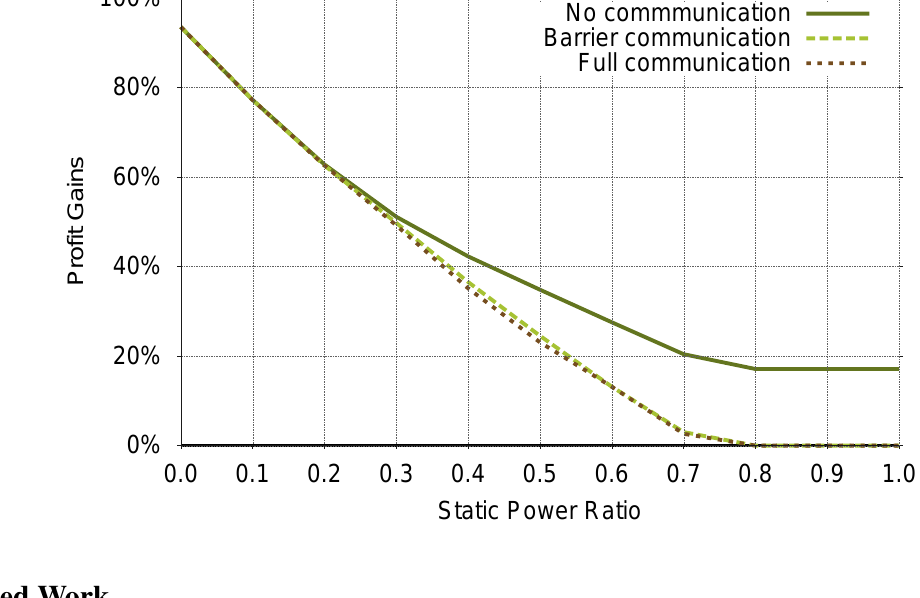
Figure 9. Profit gains of Shadow Replication over Traditional Replication for different static power ratio. MTBF = 5 years, N = 100,000, W = 1 h, t